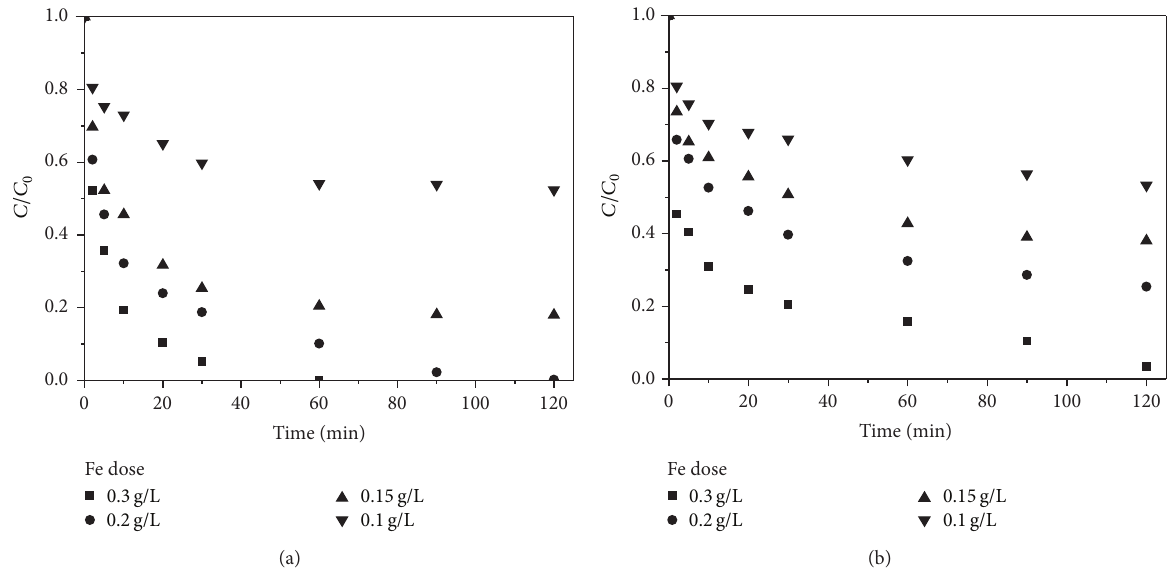
Figure 4: Effect of Fe NPs dosage on Cr(VI) (a) and Cd(II) (b) removal by Fe@SiO 2 . Initial Cr(VI) and Cd(II) concentration: 70 mg ⋅ L −1 , pH: 6.0 ± 0.1 , and temperature: 25 ∘ C.